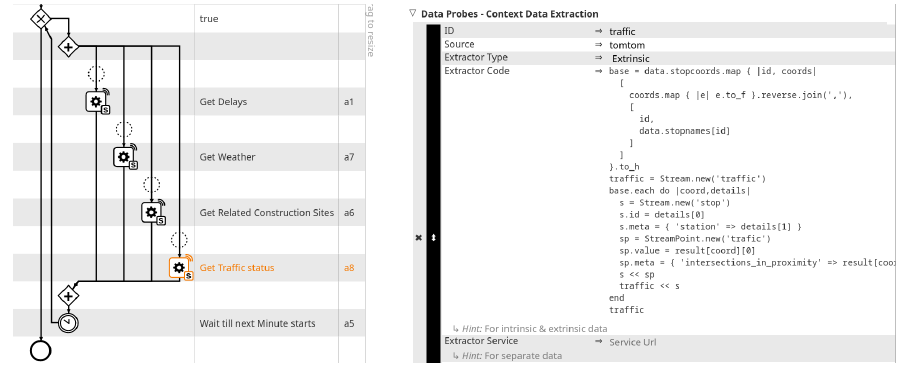
Figure 7. Data Probe(s) for the “Get Traffic Status” Task. Corresponding snippets taken out of the created log are shown in Listings 6 and 7. Listing 6 contains a snippet of the weather data in the log as collected by the task shown in Figure 6. In this excerpt of the log, different stream:point elements (as specified in the data probes of the task) are contained in the stream:datastream